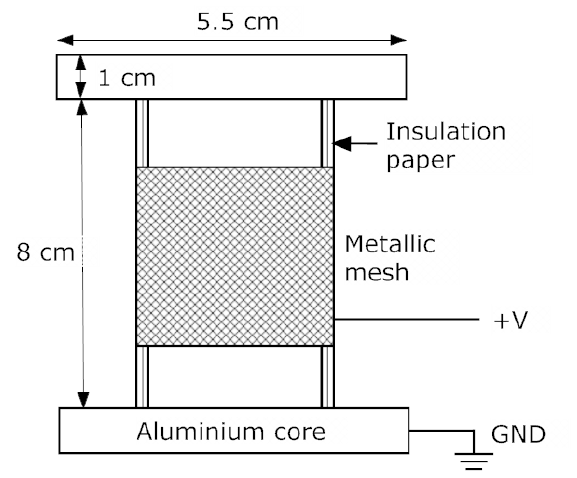
Figure 1. Layout and dimensions of the prototypes with the metallic mesh and the layers of insulation paper.